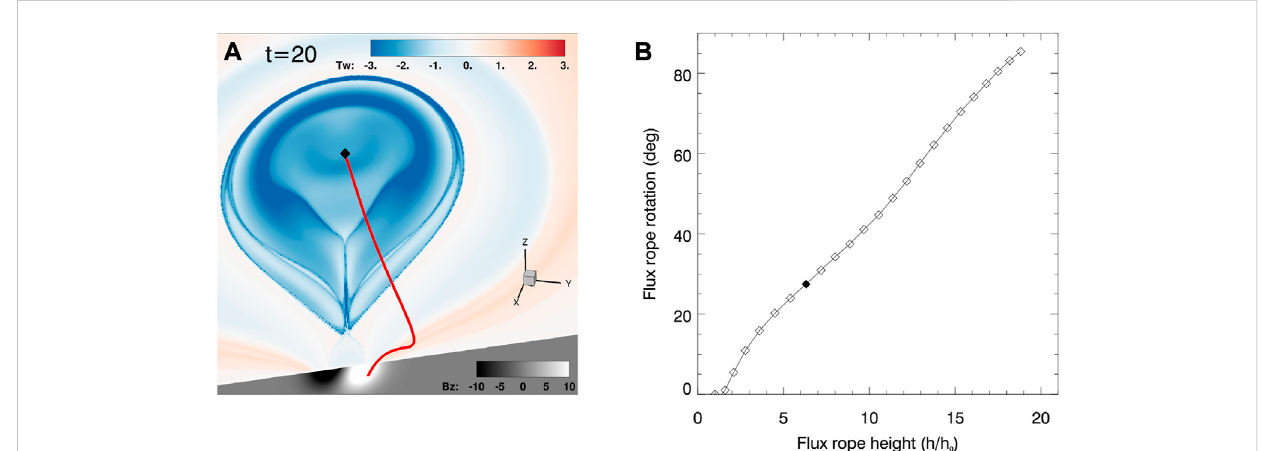
FIGURE 2 (A) The distribution of twist number (at t = 20 t s ) on the normal plane that is perpendicular to the tangent vector of MFR ’ s axis (the red curve) at the apexpoint(black fi lleddiamond, h =6.32 h